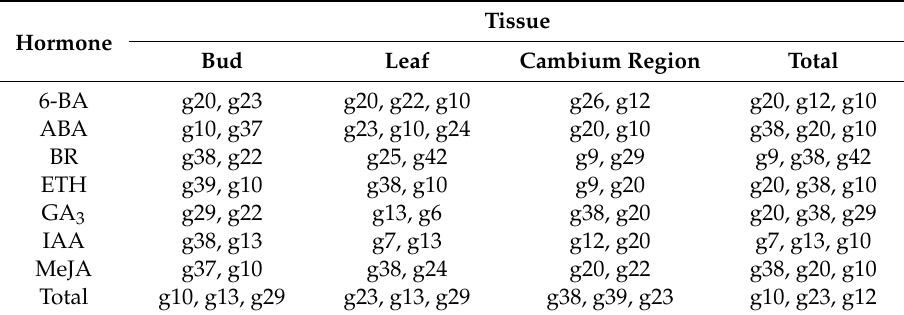
Table 3. The most stable reference genes under di ff erent hormone stress. Tissue Hormone Bud Leaf Cambium